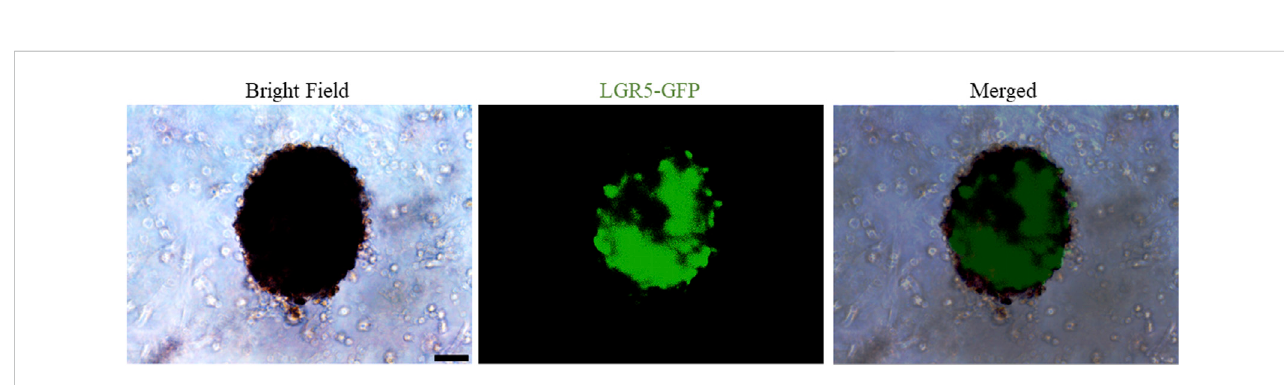
FIGURE 2 Representative images of bright- fi eld and fl uorescence of LGR5 + -embryonic joint progenitors-based cartilage organoids formation. Scale bars = 100 µm.